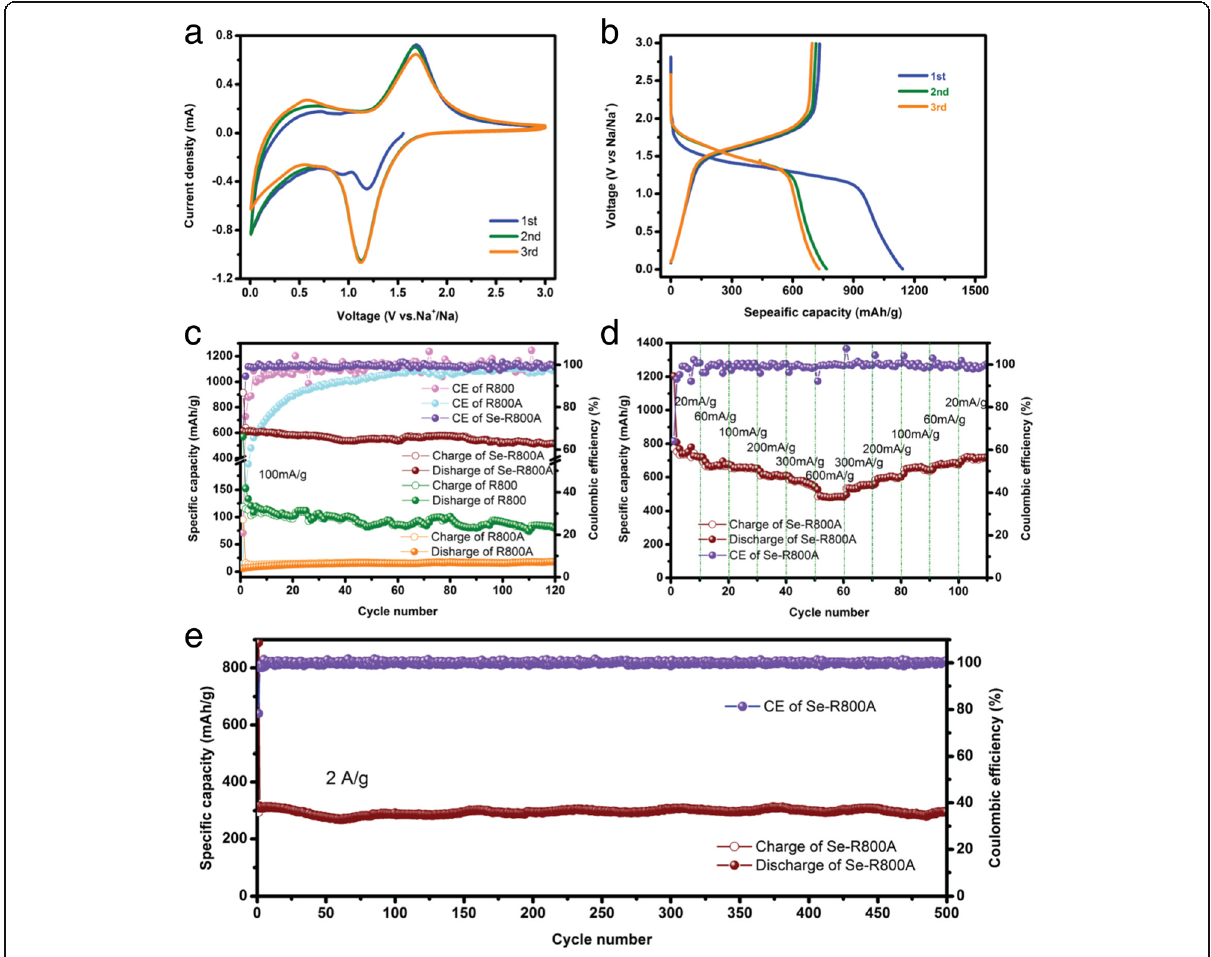
Fig. 5 The electrochemical performance of the Se-R800A cathode in Na-Se batteries, a the CV curves at scan rate of 0.2 mV s − 1 , b the galvanostatic discharge/charge voltage profiles tested at 50 mA g − 1 , c the cycling performance of the Se-R800A, R800A, and R800 at 100 mA g − 1 , d the rate capability at various current densities, and e the cycling performance of the Se-R800A at 2 A g − 1